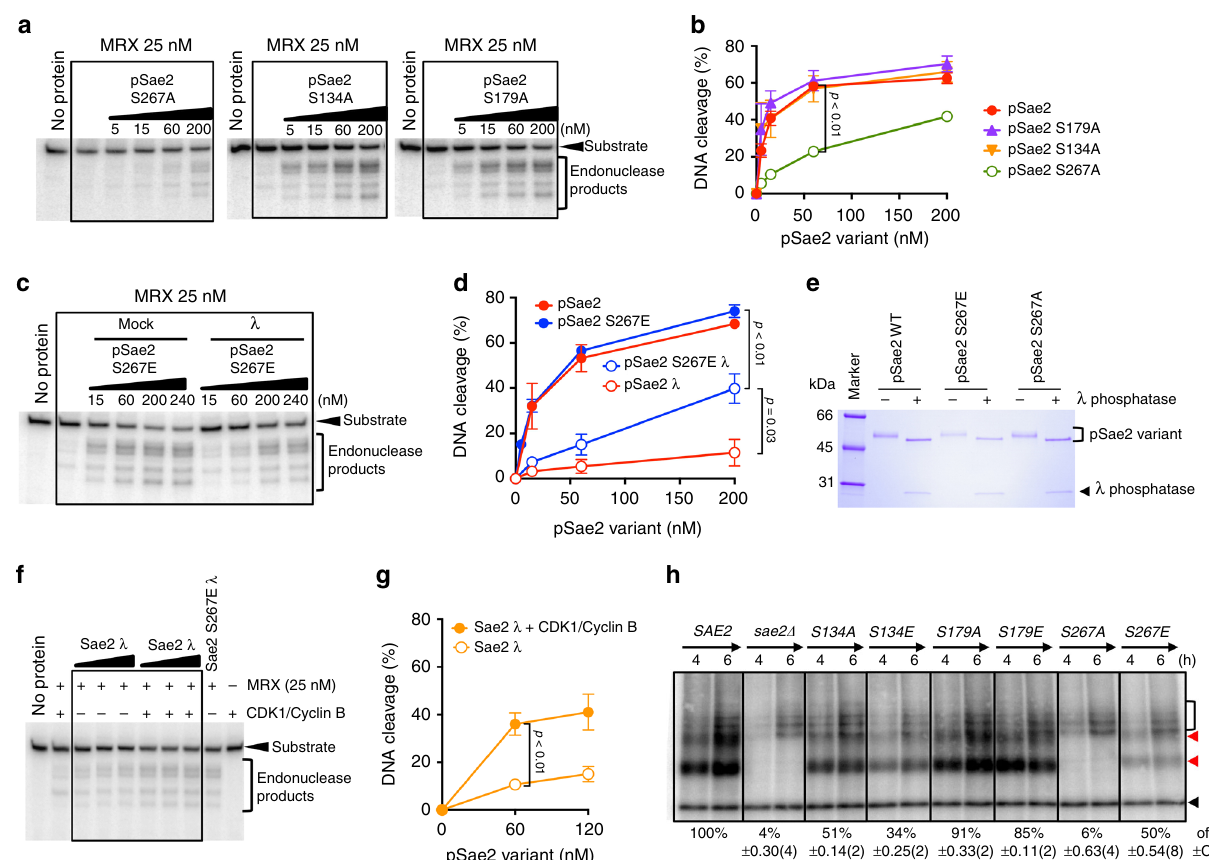
Fig. 3 CDK phosphorylation of Sae2 is prerequisite, but not suf fi cient, to promote the MRX nuclease. a Nuclease assays with MRX and pSae2 variants mutated in one of the three CDK consensus sites (S267, S134, and S179) into alanine. All mutants were expressed in the presence of phosphatase inhibitors. Substrate used was the same as in Fig. 1c. b Quantitation of the assays such as shown in a ; error bars, SEM; n ≥ 3. c Nuclease assays with pSae2 S267E phosphomimicking variant, expressed in the presence of phosphatase inhibitors. The pSae2 S267E protein was mock or λ phosphatase treated, as indicated. d Quantitation of assays such as shown in c ; error bars, SEM; n ≥ 3. e Representative polyacrylamide gel (4 – 15%) electrophoretic analysis of the indicated pSae2 variants, treated or not with λ phosphatase, stained with Coomassie brilliant blue. f Sae2 was expressed and dephosphorylated with λ phosphatase during puri fi cation (Sae2 λ ). The polypeptide was then mock-treated or phosphorylated with recombinant CDK1/Cyclin B, where indicated, and used in nuclease assays (60, 120, and 200 nM, respectively) with MRX. The pSae2 S267E variant treated with λ phosphatase (pSae2 S267E λ , 200 nM) was used as a reference. g Quantitation of assays such as shown in f ; error bars, SEM; n ≥ 3. h Spo11-oligonucleotide assay, as in Fig. 2f, performed in sae2 Δ cells with wt, and sae2 mutant bearing non-phosphorylatable (S → A) or phosphomimicking (S → E) mutations in the CDK consensus sites of Sae2 expressed from a centromeric vector. Quantitation is shown below the lanes as an average (relative to wild type) ± coef fi cient of